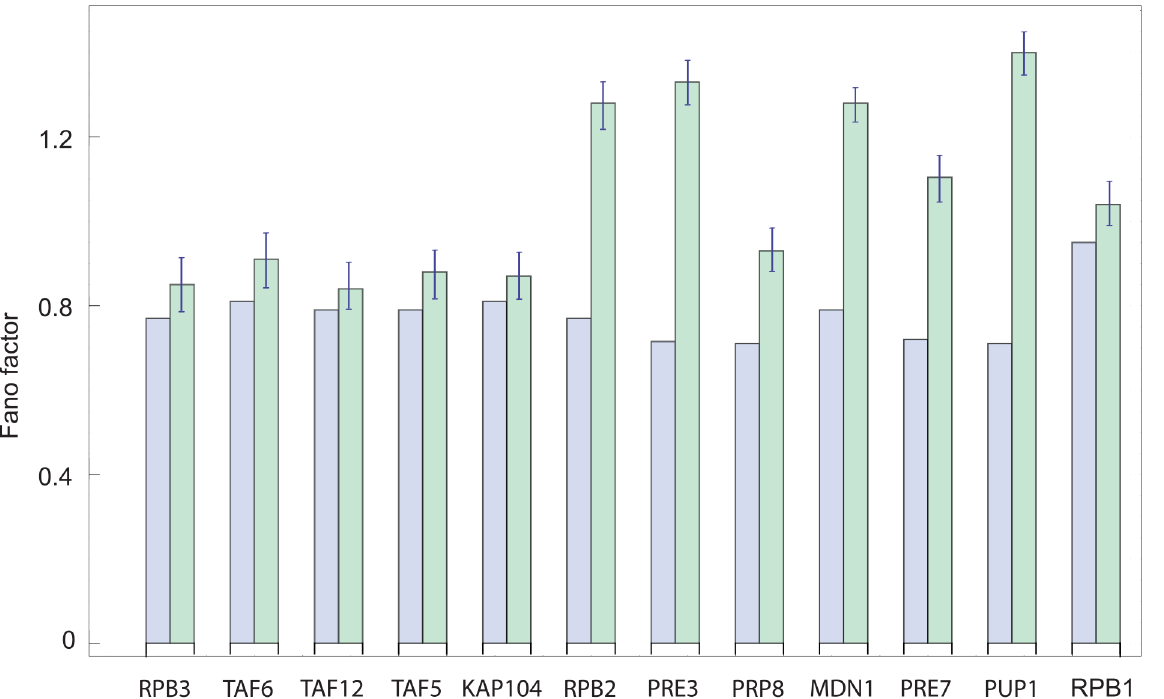
Fig 4. Comparison of predicted and measured Fano factors for cytoplasmic mRNA distributions. Fano factors for the cytoplasmic mRNA distributions, as predicted by the one-step (RPB1), two-step (KAP104, TAF5, TAF6, TAF12, RPB2, RPB3, MDN1) and three-step (PUP1, PRE3, PRE7, PRP8) mechanisms of initiation, are shown as blue bars. These are compared with the measured cytoplasmic mRNA distributions, shown in green bars, as reported in ref [25]. In cases when the measured distributions have higher Fano factors than predicted, this is indicative of significant sources of noise downstream to transcription initiation and elongation that affect the cell-to-cell variability of cytoplasmic mRNA.